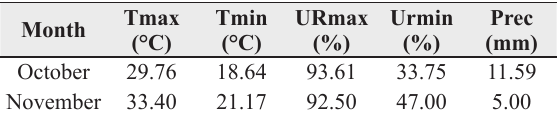
Maximum (Tmax) and minimum (Tmin) temperature, maximum relative humidity (URmax) and minimum (URmin) and precipitation (Prec) for the city of Dourados- MS during the months of October and November 2009.